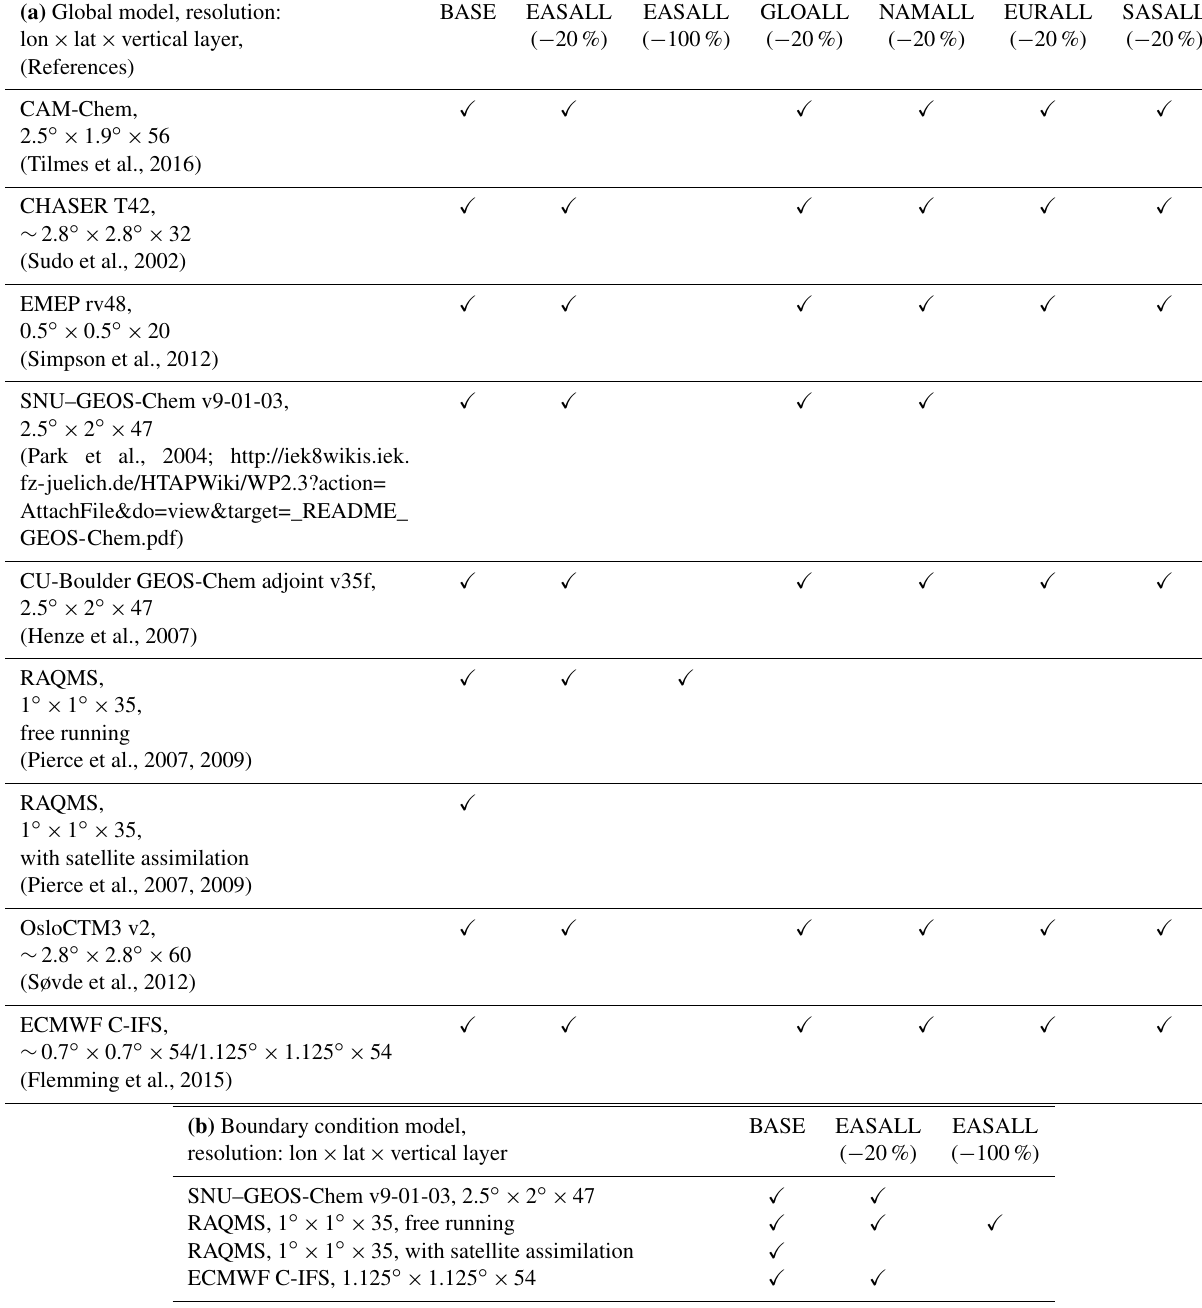
Table 1. (a) HTAP2 base and sensitivity simulations by various global models. (b) STEM regional simulations for HTAP2. (c) STEM and its boundary condition models’ key inputs and chemical mechanisms, with references. More details on the models can be found in (a) and the